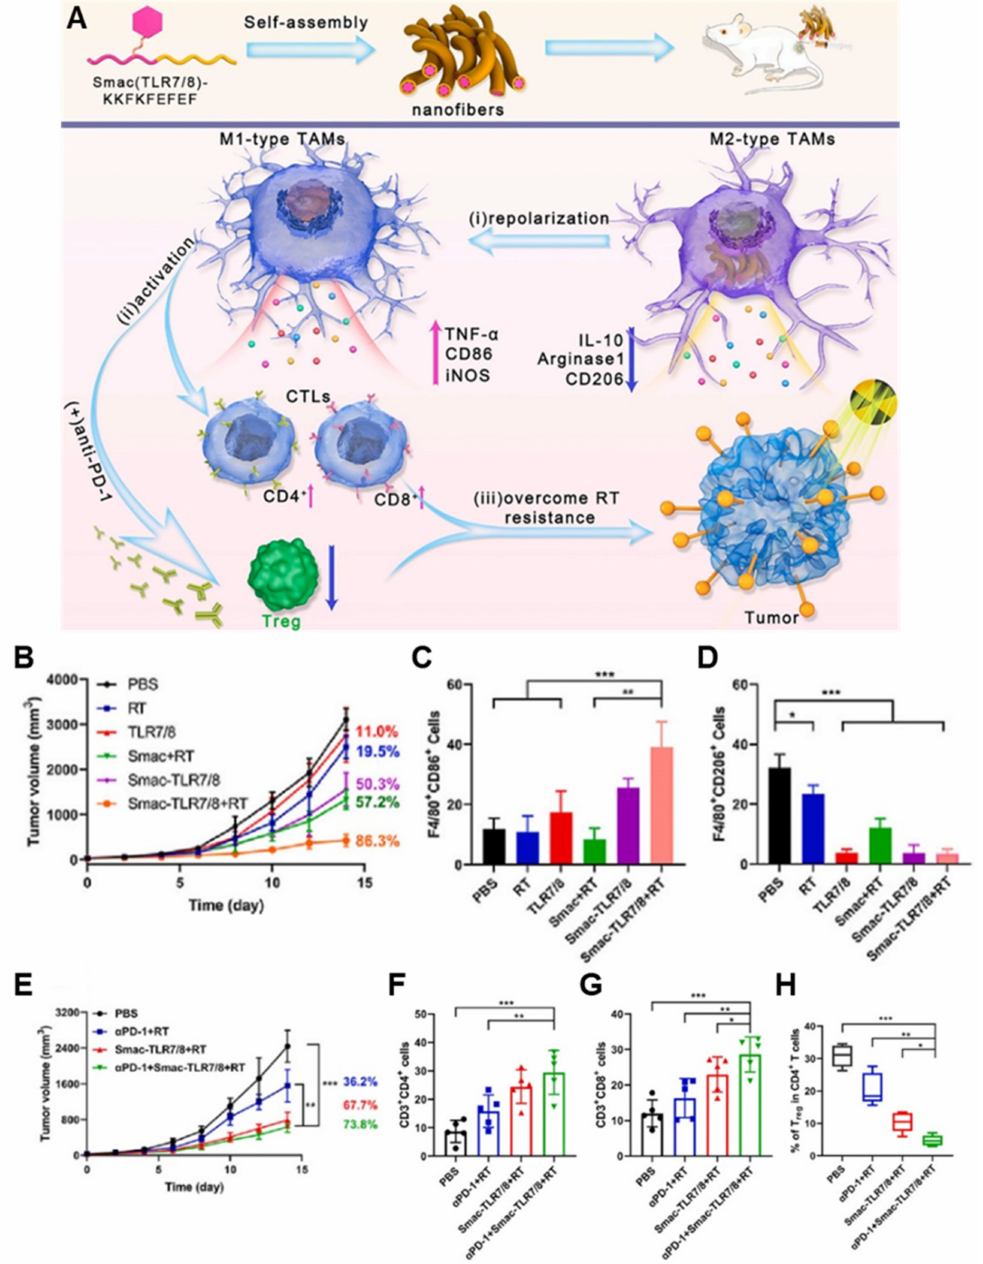
Figure 6. Injectable self-assembled hydrogel with radiosensitive peptide and TLR7/8 agonist for combination radioimmunotherapy. ( A ) Schematic illustration of Smac-TLR7/8 hydrogel overcoming radioresistance by macrophage repolarization. ( B ) Tumor growth curves after treatments. ( C ) M1 and ( D ) M2 macrophage proportions within the tumor tissues quantitatively analyzed by flow cytometry. ( E ) Tumor growth curves after ICB-combined treatments. Populations of ( F ) CD4 + , ( G ) CD8 + , and ( H ) regulatory T cells in tumors analyzed using flow cytometry. * p < 0.05, ** p < 0.01, *** p < 0.001, one-way ANOVA for indicated comparison. Figures are reproduced from [54], with permission from